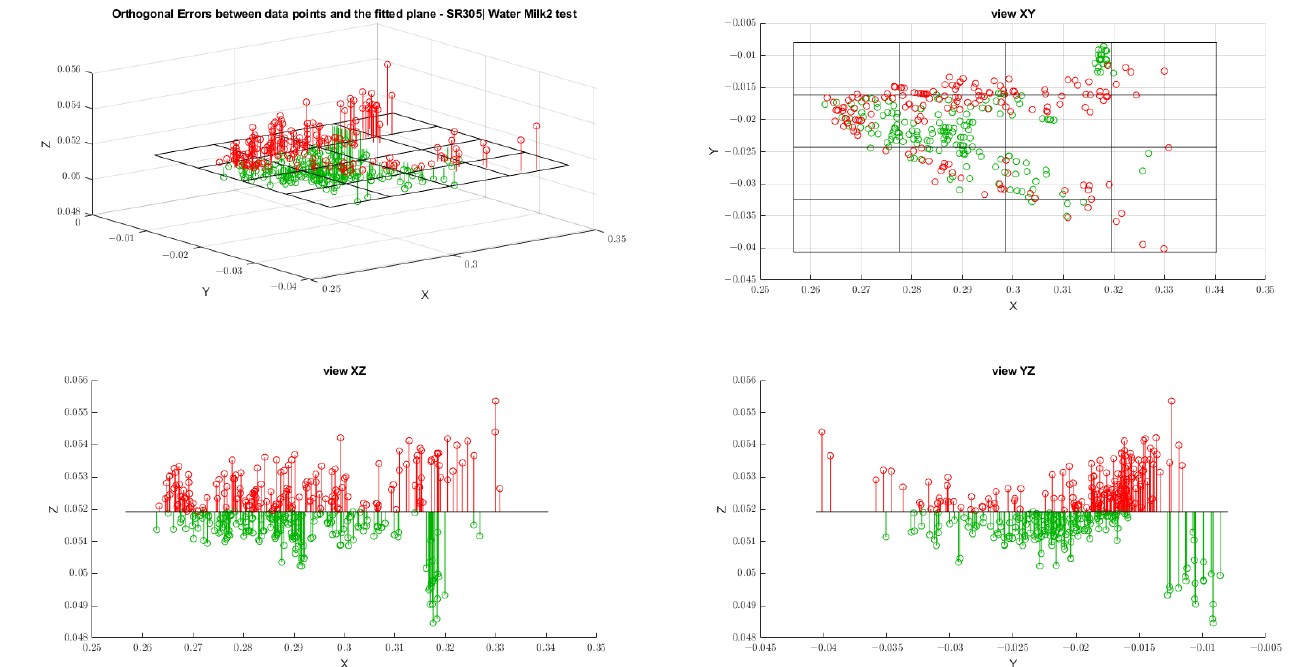
Figure A19. Results of orthogonal errors for the SR305 camera referring to the water milk2 test.